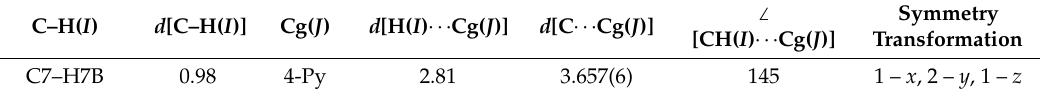
Table 3. C–H ··· π ring interactions distances (Å) and angles ( ◦ ) for [PbL(NO 2 )] n a .